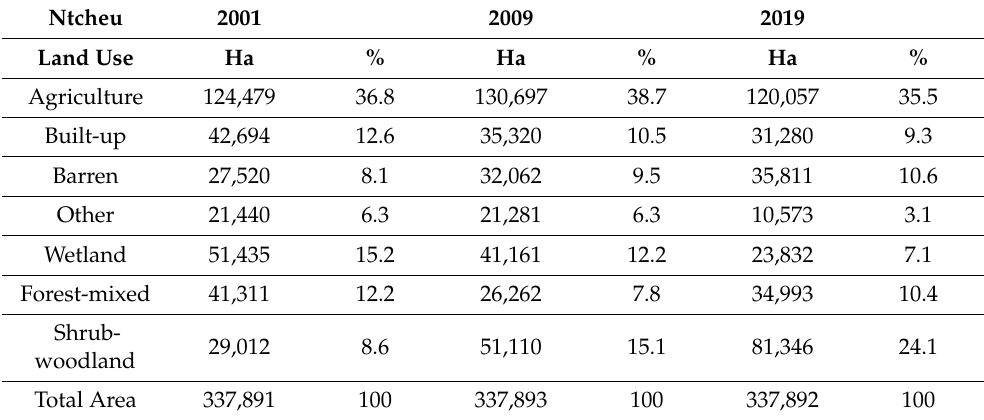
Table 5. Land-cover distribution and statistics summary in Ntcheu district (Ha =